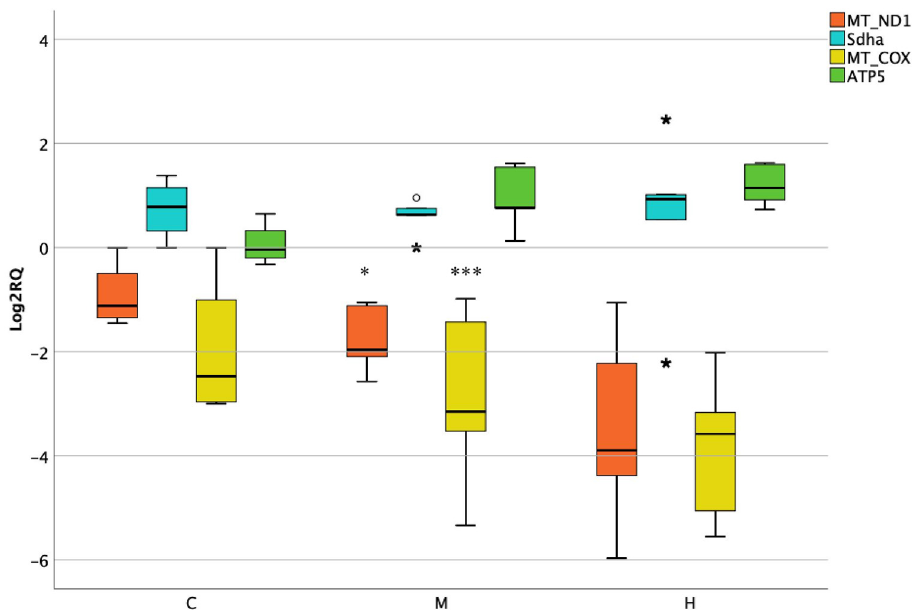
Figure 4. Box plot showing relative expression of mitochondrial and nuclear encoded genes in lower intestine when compared to control C1 (Log2RQ = 0) to medium treatment (M) and high treatment (H) by qPCR. RQ, relative quantification. The box plots show the median value (horizontal line), the top and bottom edges of the boxes (75% and 25% percentiles), ( (cid:70) ) extreme case and whiskers, which are the furthest values away from the boxes that are not considered outliers. * p < 0.05; *** p < 0.001 significantly different from the